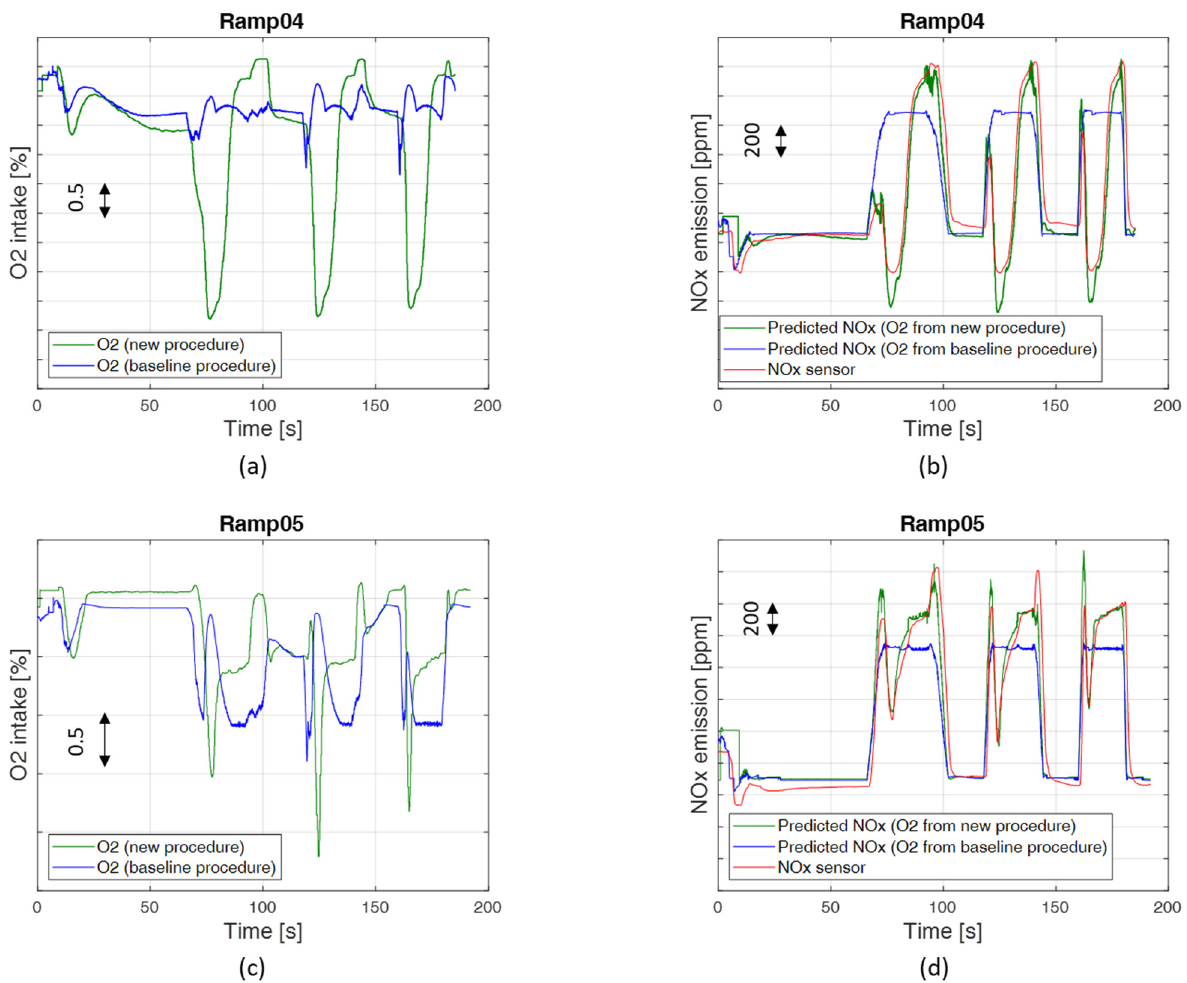
Figure 12. ( a , c ): Time histories of the ECU-derived intake O 2 concentration values (blue lines) and of the intake O 2 concentration values evaluated by means of the new procedure (green lines). ( b , d ): Time histories of the engine-out NOx values predicted by the combustion model using the intake O 2 concentration derived from the baseline ECU-derived procedure (blue line) and the intake O 2 concentration evaluated by the new procedure (green lines), together with the values of the NOx emissions measured by the NOx sensor (red lines) for ramp tests 4 and 5.